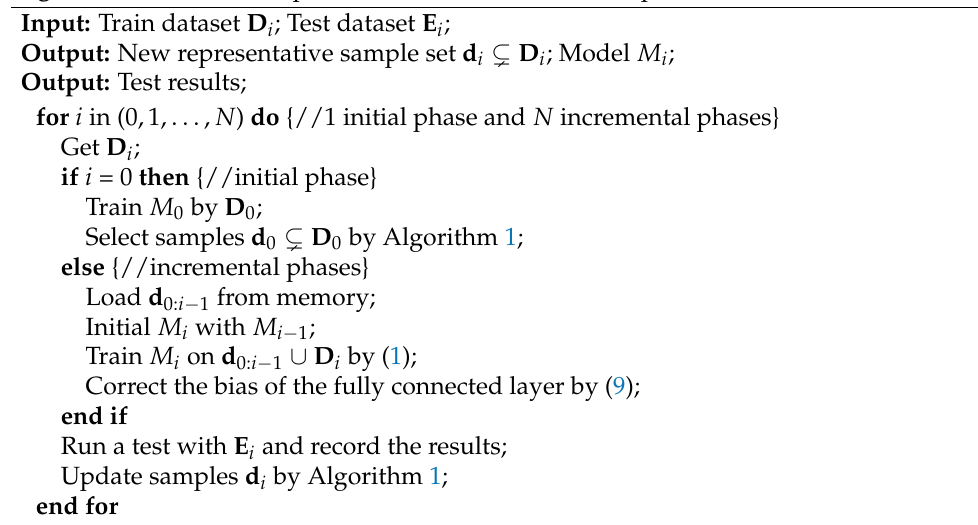
Algorithm 2: Detailed Implementation Process of the Proposed Method.